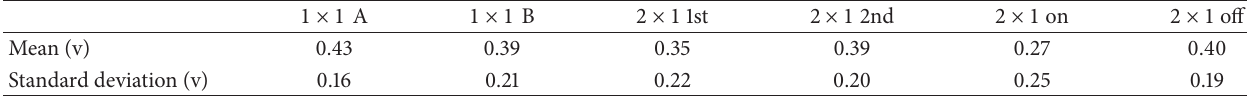
Table 2: Mean and standard deviation of measured BER.